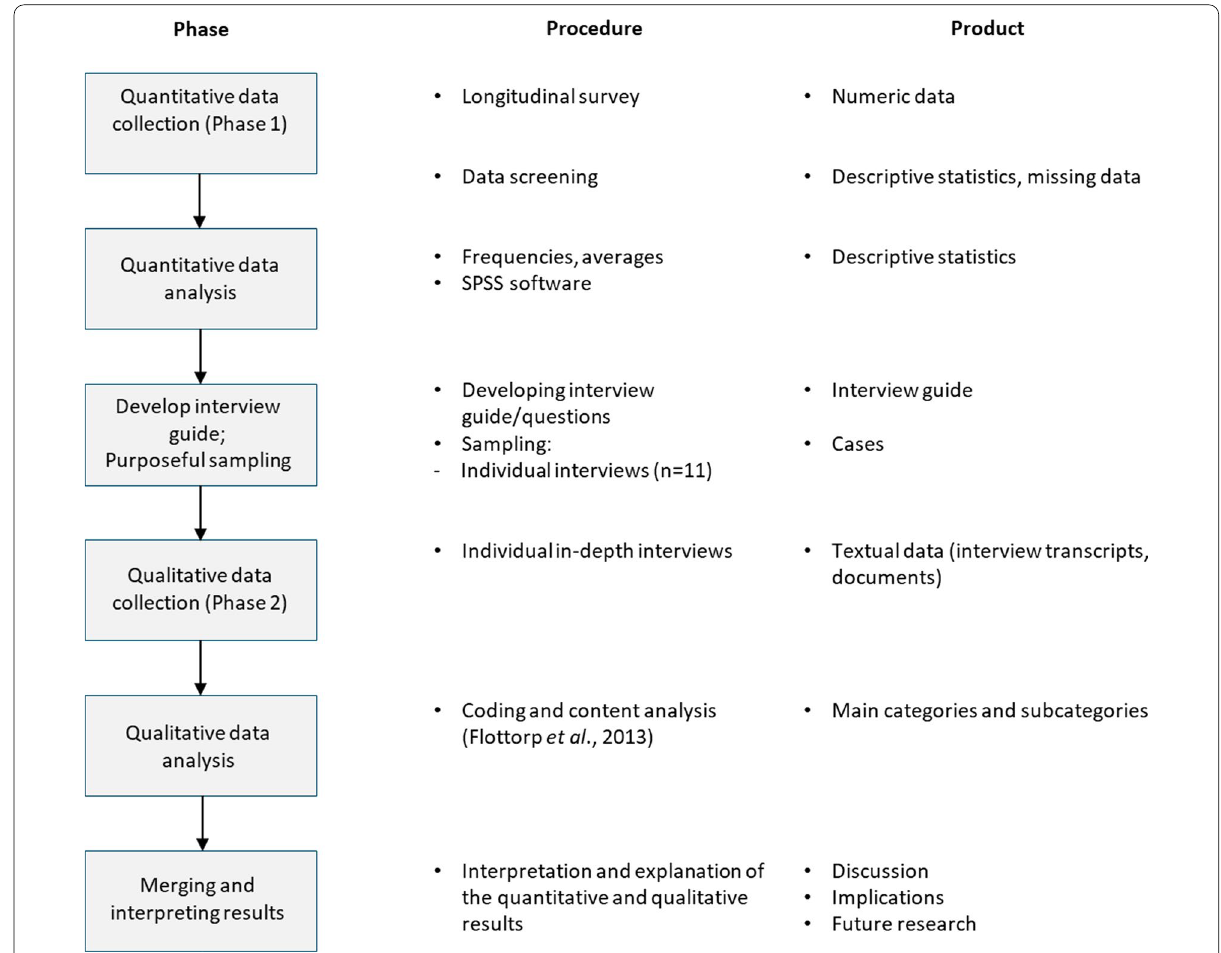
Fig. 1 Diagram of the study. A sequential explanatory mixed method